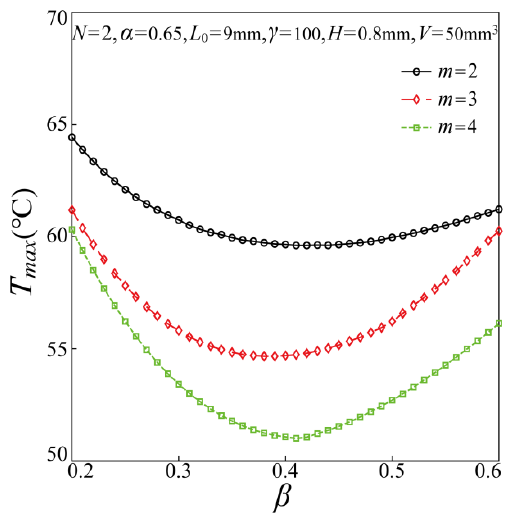
Figure 5. Effect of β with different m on the maximum temperature of the chip.